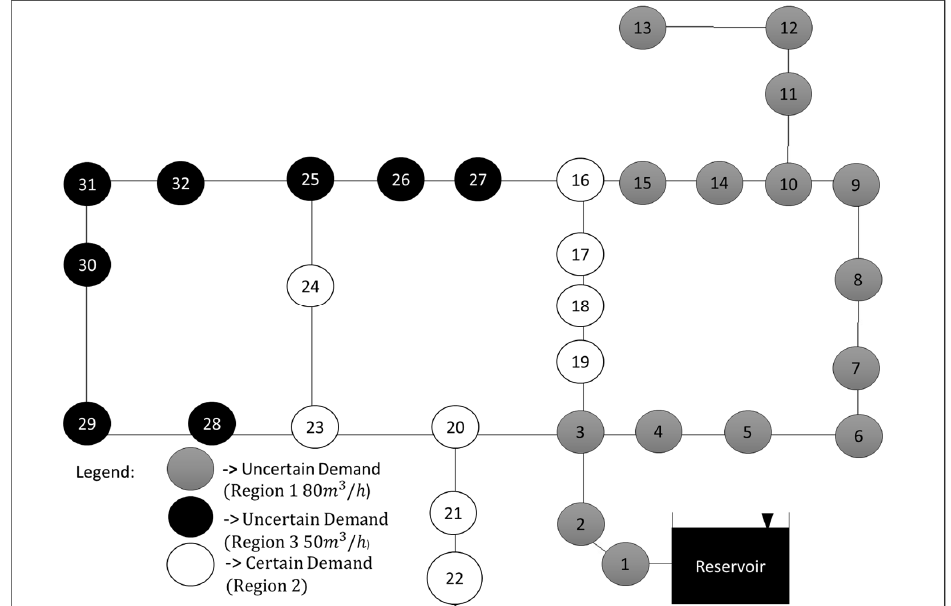
Figure 2. Graphical representation of Hanoi WDS with junctions as nodes and pipes as links.